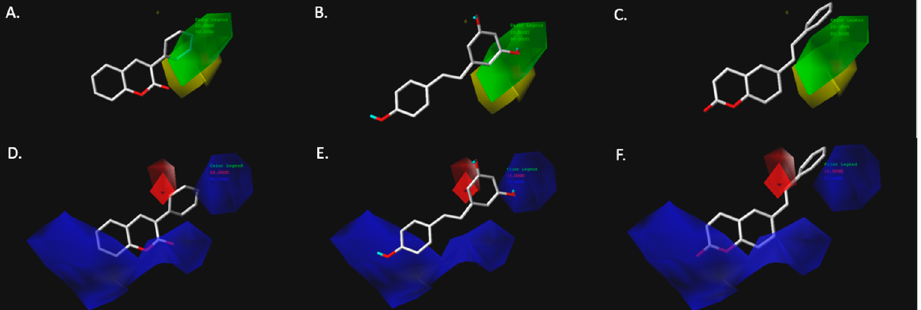
Figure 6. Overlay of trans -resveratrol, 3-phenylcoumarin and trans -6-styrylcoumarin on the contour map obtained from the MAO-B CoMFA model. ( A ) Trans -resveratrol and steric map. ( B ) 3-Phenylcoumarin and steric map. ( C ) trans -6-Styrylcoumarin and steric map. ( D ) Trans -resveratrol and electrostatic map. ( E ) 3-Phenylcoumarin and electrostatic map. ( F ) trans -6-Styrylcoumarin and electrostatic map. Color code: steric contour map green—bulky groups are favorable for the activity; steric contour map yellow—small groups are favorable for the activity; electrostatic contour map red—negative charge is favorable for the activity; electrostatic contour map blue—positive charge is favorable for the activity; hydrophobic contour map yellow—hydrophobic groups are favorable for the activity; hydrophobic contour map grey—hydrophilic groups are favorable for the activity.